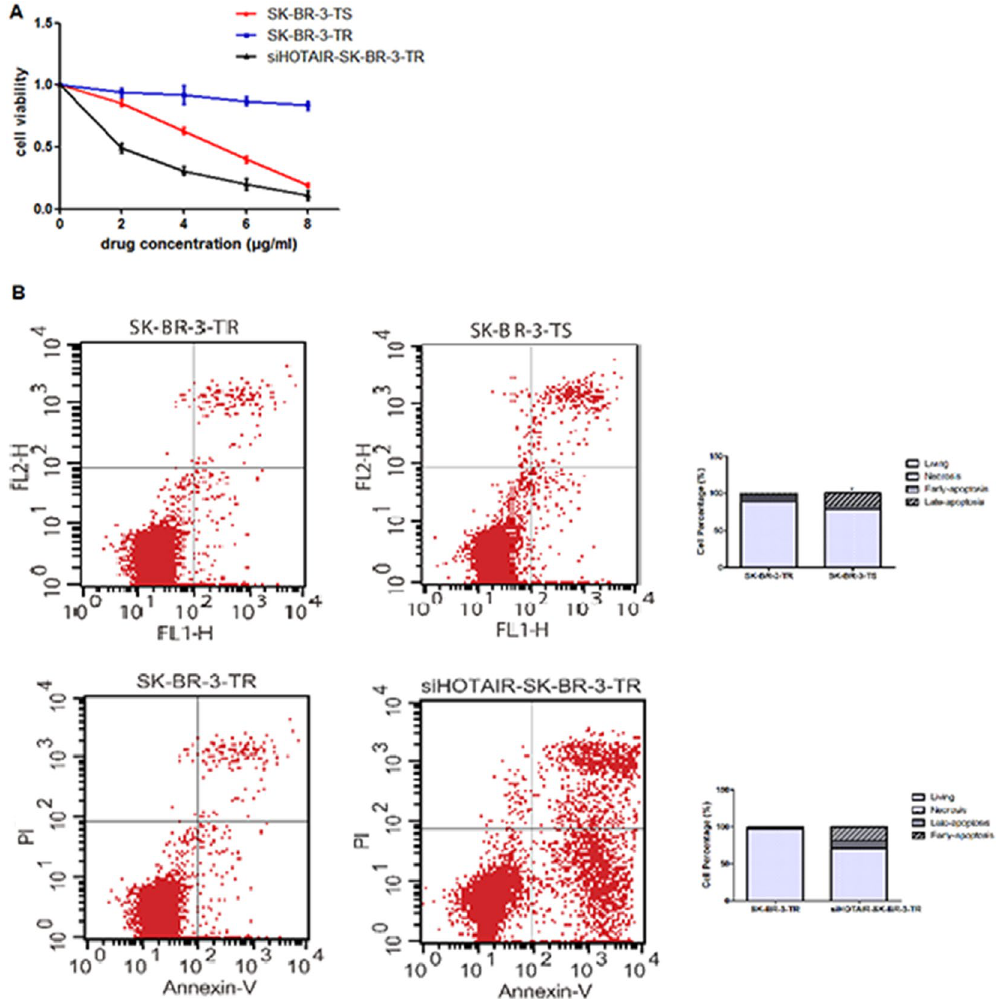
Figure 3. Relative viability and apoptosis of breast cancer cells treated with trastuzumab and following HOTAIR knockdown. ( A ) Cell viability; ( B )